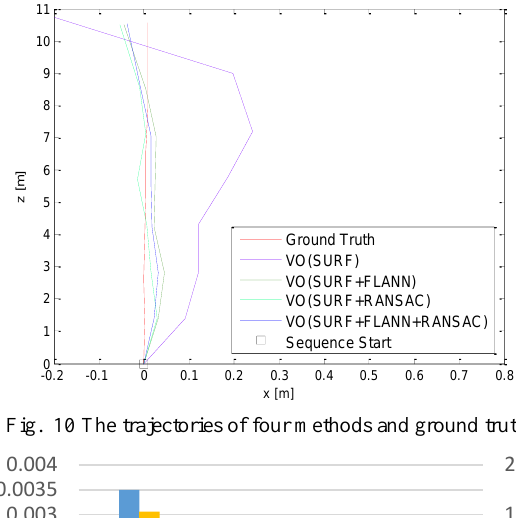
(a) Corner detection.